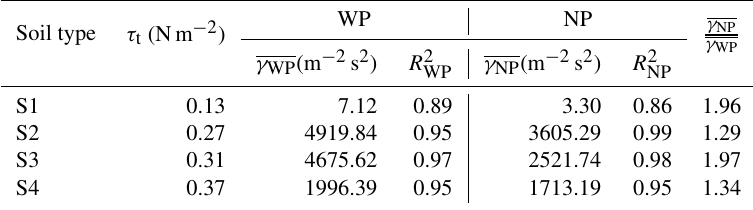
Table 3. Threshold shear stress τ t and empirical parameter γ for test